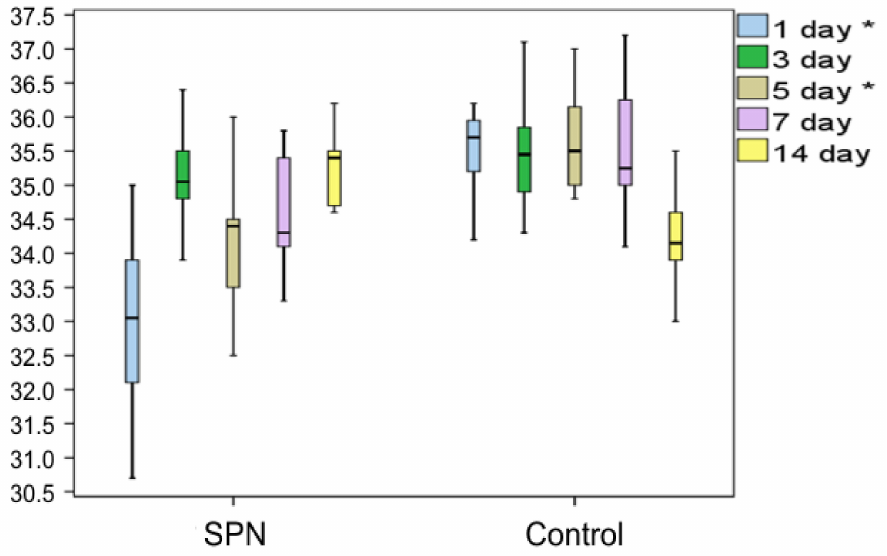
Figure 2. Changes in the temperature of the wound center ( ◦ C). * indicates a di ff erence between the groups on Day 1 and Day 5 p < 0.05 (the Mann–Whitney